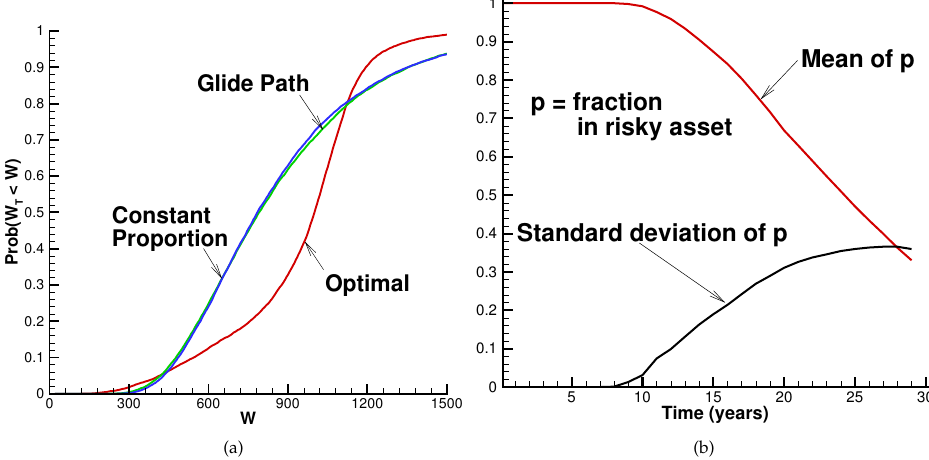
Figure 3. Base case scenario results in the historical market. Input data provided in Tables 1 and 2. Results based on 10,000 bootstrap resampled paths using data from 1926:1 to 2015:12 with expected blocksize ˆ b = 2 years. ( a ) cumulative distributions of real terminal wealth for various strategies. Wealth units: thousands of dollars; surplus cash included for the QS optimal case; ( b ) mean and standard deviation of the fraction allocated to the equity market for the QS optimal